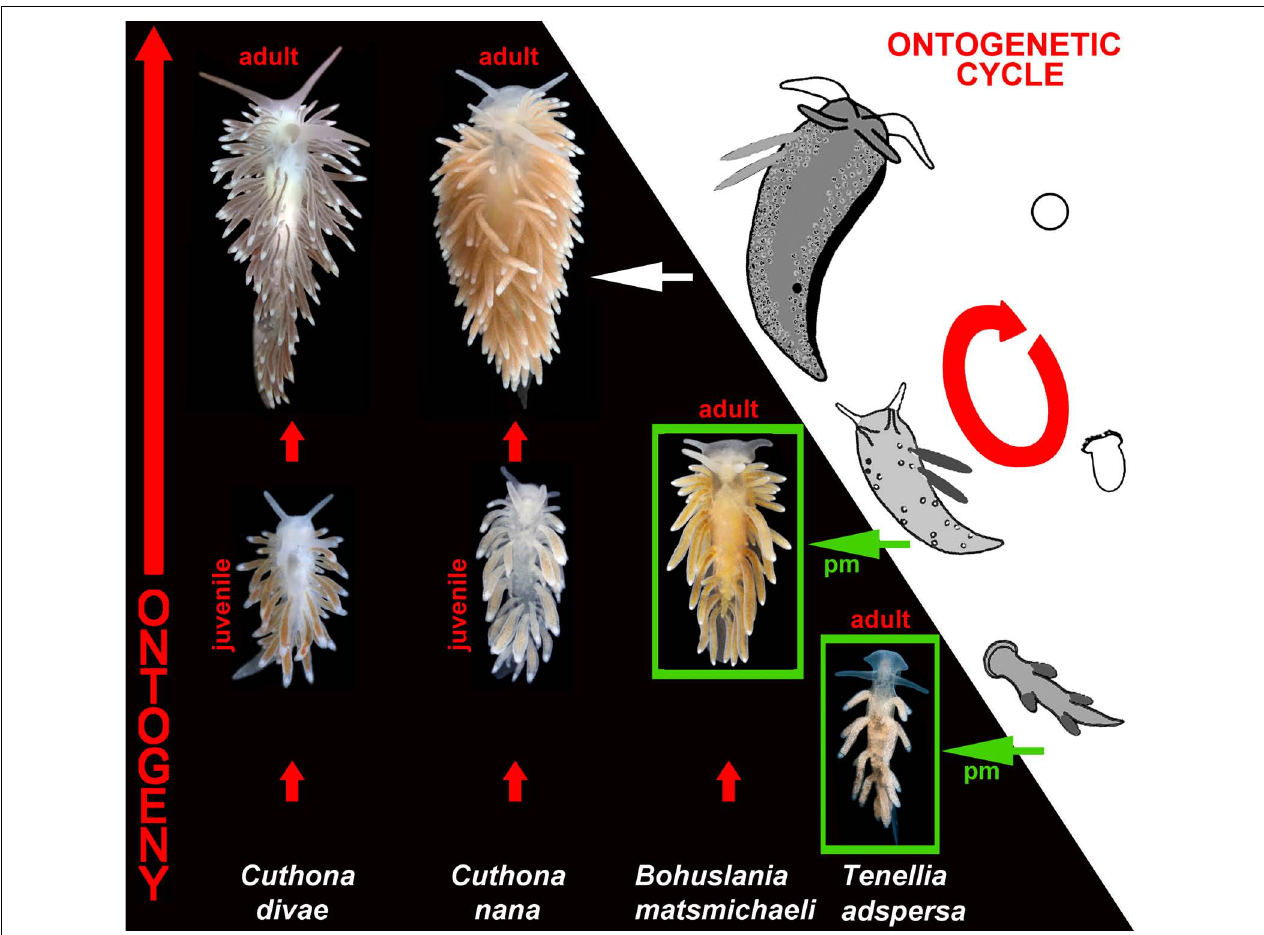
FIGURE 3 | Ontogenetic-and-evolutionary linkage through the modifications of the ontogenetic cycles of aeolidacean nudibranchs. Note significant similarity between aeolidacean ontogenetic periods (hence, phylotypic periods) and adult organization of particular paedomorphic (pm) aeolidacean taxa (e.g., Bohuslania and Tenellia , green boxes). See Korshunova et al. (2018) and Martynov et al. (2020) for molecular phylogenetic